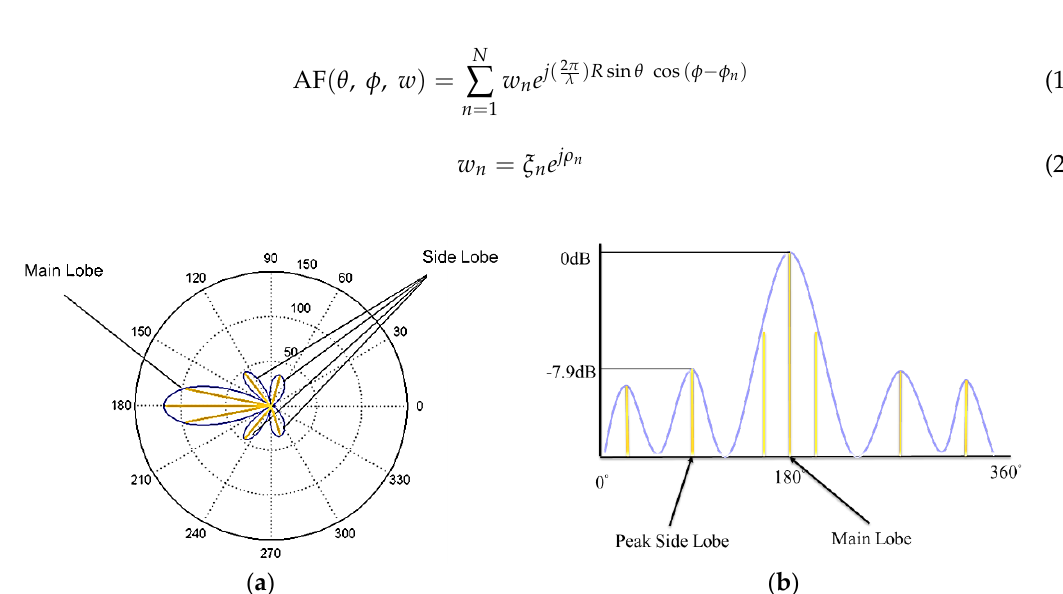
Figure 6. ( a ) The beam pattern of an antenna array beamforming, and ( b ) its associated Cartesian coordinate representation.